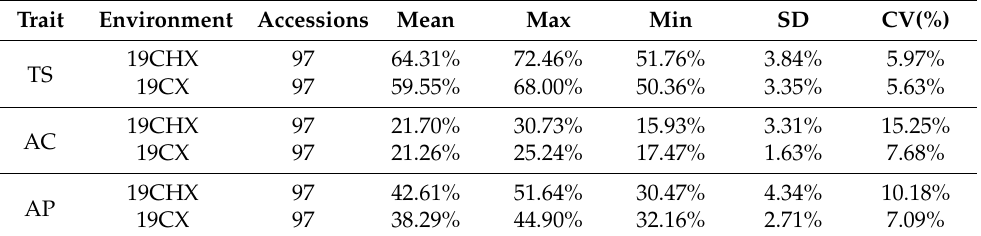
Table 1. Phenotypic variation for TS, AC and AP in the association population.